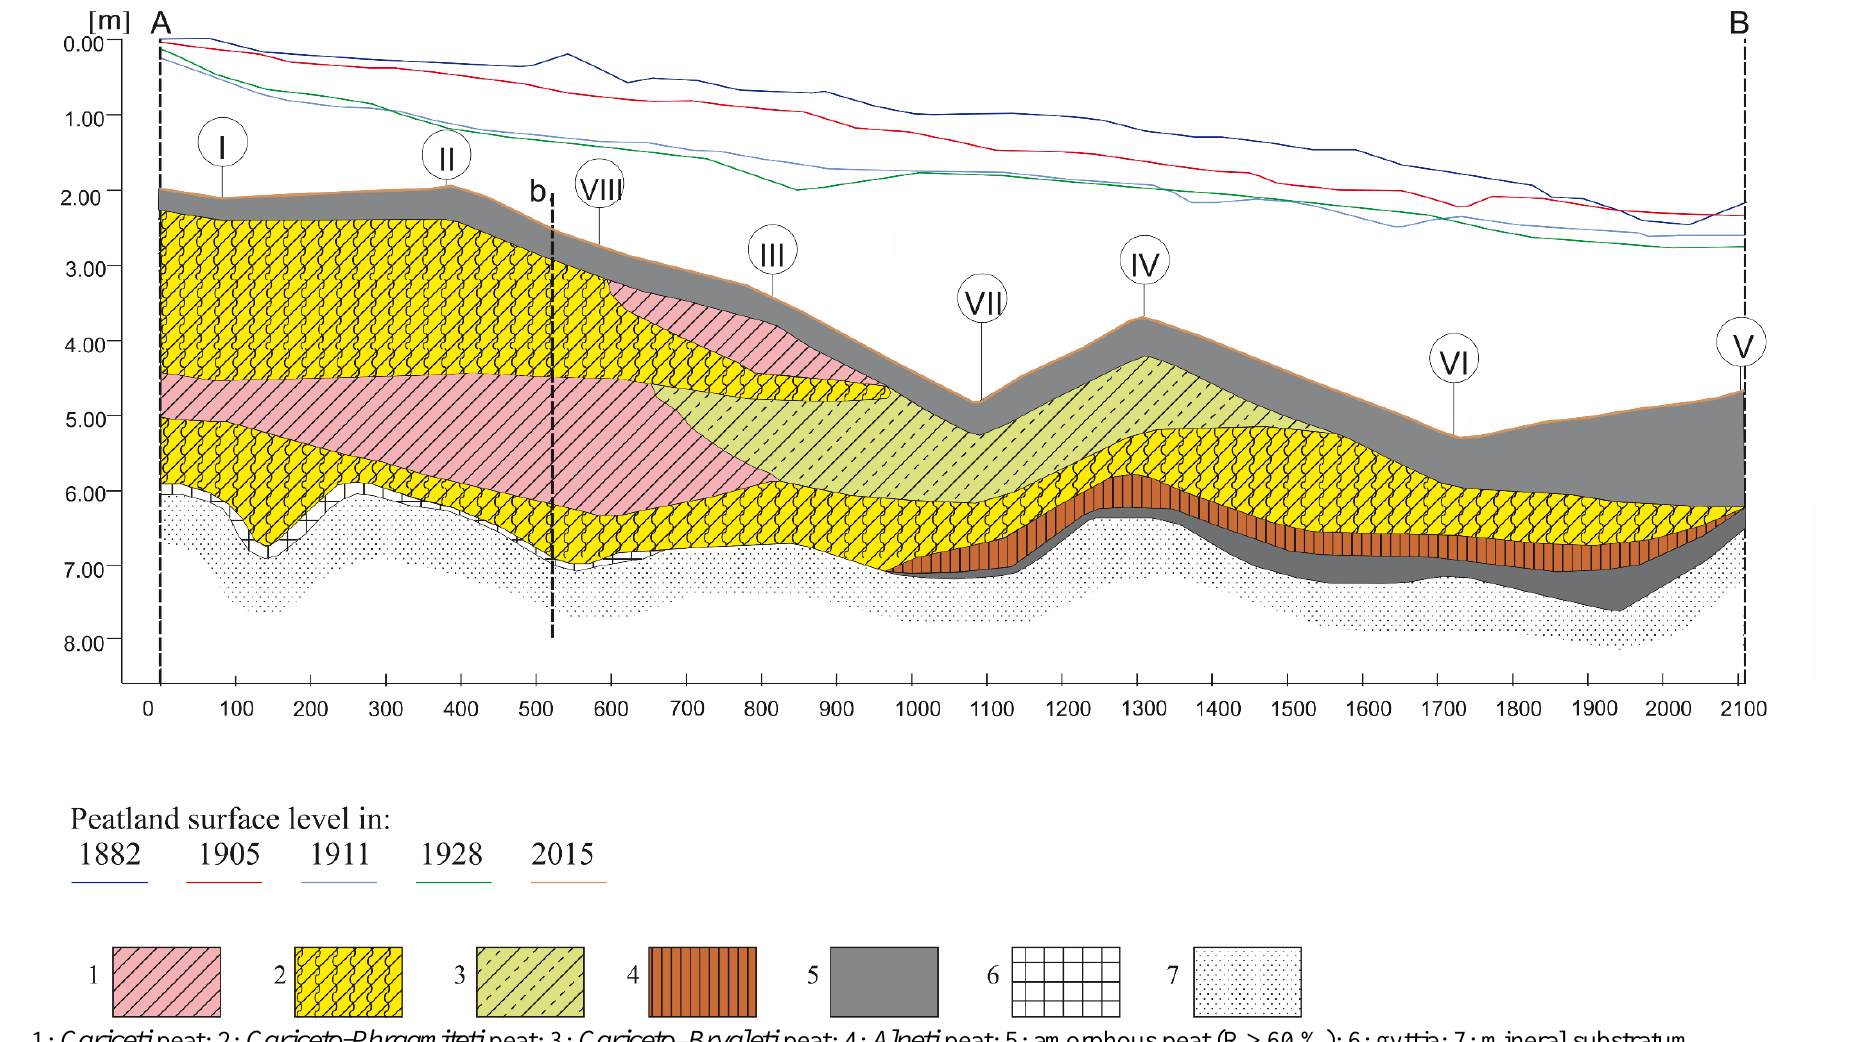
Figure 3. Historic height levels and current stratigraphic profile based on peat corings along Transect A–B in the Dublany peatland. I, II… Numbering of